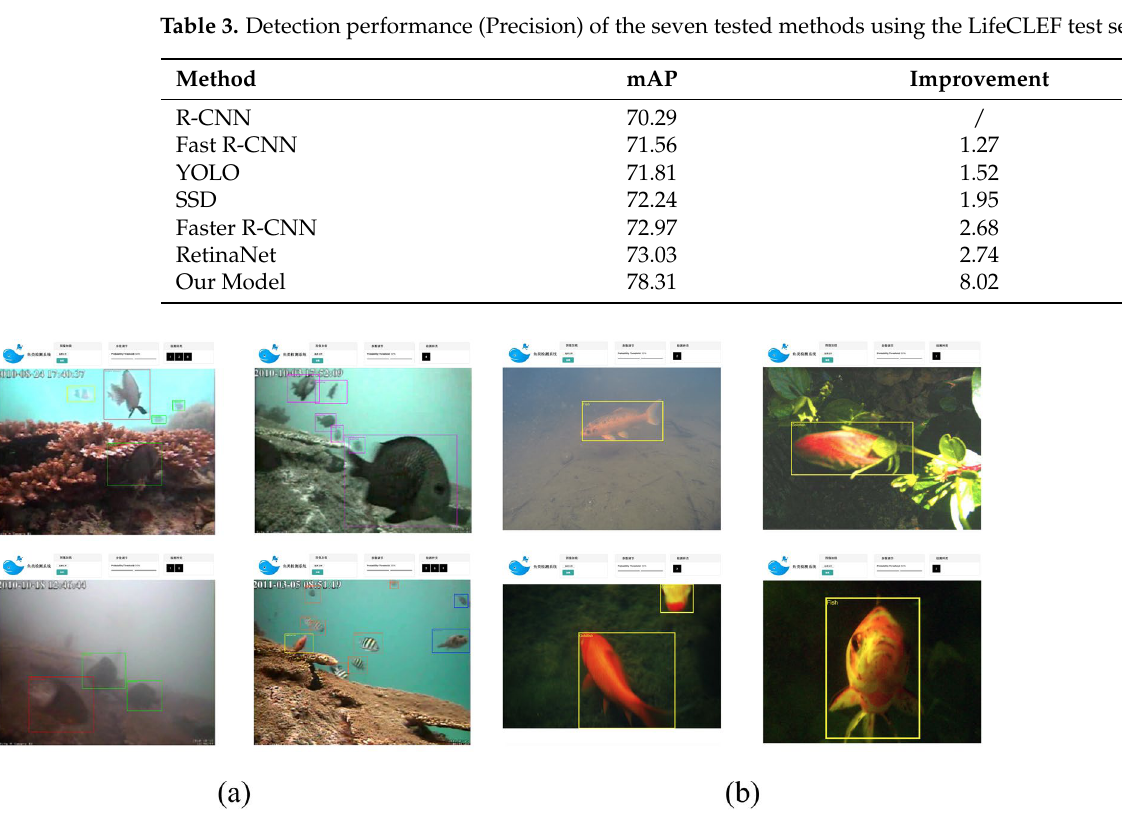
Figure 11. ( a ) Test results on the Fish4Knowledge [30] dataset; ( b ) test results on the data from the field experiment.